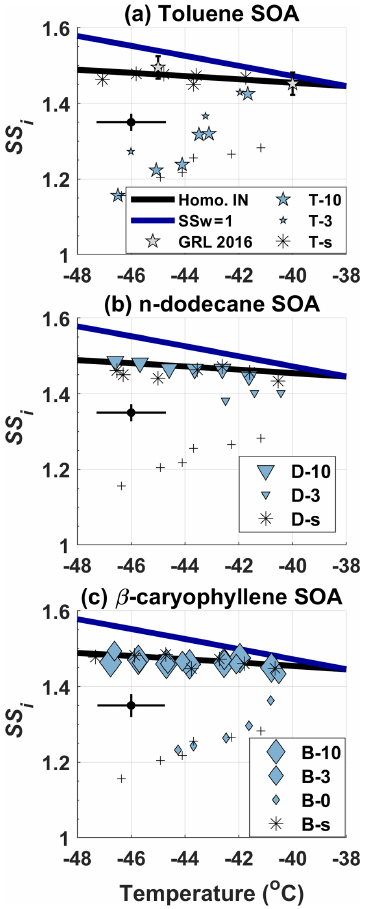
Figure 5. IN-onset SS i phase diagram of 350nm COJ300 BC parti- cles coated with (a) toluene SOA, (b) n -dodecane SOA, and (c) β - caryophyllene SOA. Different symbol sizes denote different OH ex- posure levels. IN-onset SS i of 350nm bare COJ300 is shown with black plus symbols for comparison. Pure SOA IN-onset SS i are pre- sented as asterisks for each organic species, respectively. The solid blue and black lines are water saturation lines and homogeneous lines for 200nm aqueous droplets (Koop et al., 2000), respectively. A representative SPIN lamina temperature and SS i error bar is given on the left side of each panel. The toluene-SOA-coated diesel BC IN data from Kulkarni et al. (2016) are also included for